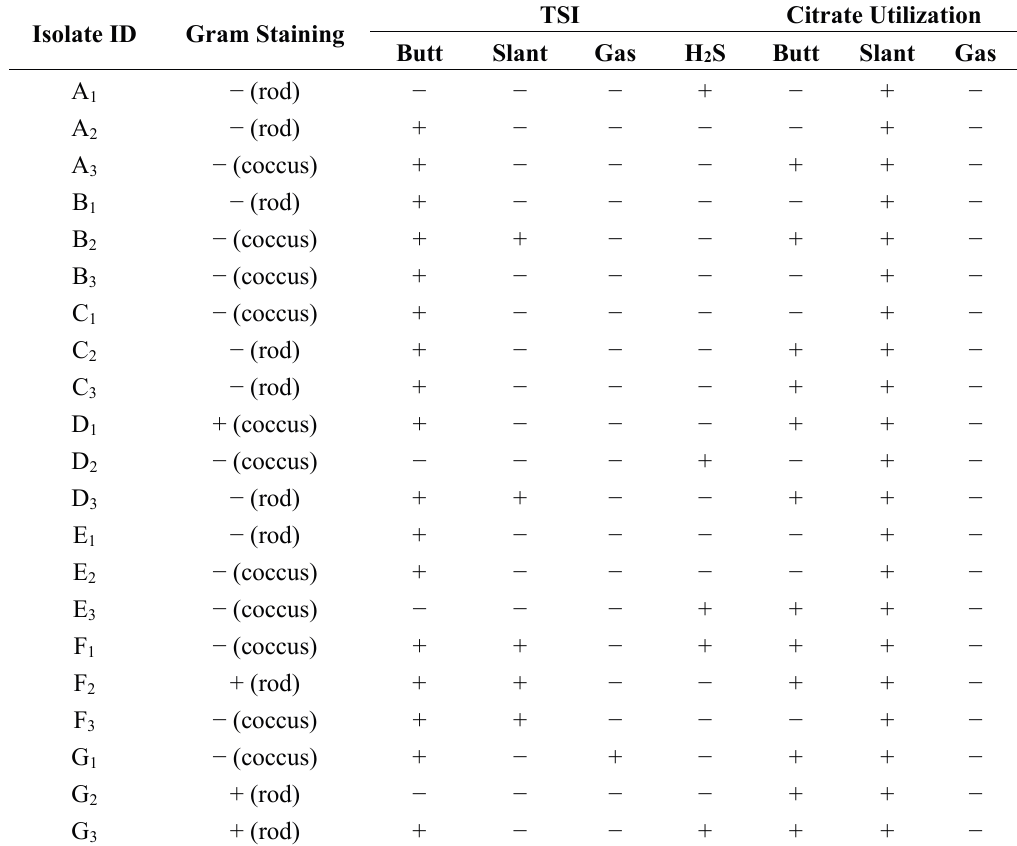
Table 4. Preliminary identification test results for presumptive coliform bacteria isolates with m-ENDO agar (+ = positive for the test; − = negative for the test). TSI Citrate Utilization Isolate ID Gram Staining